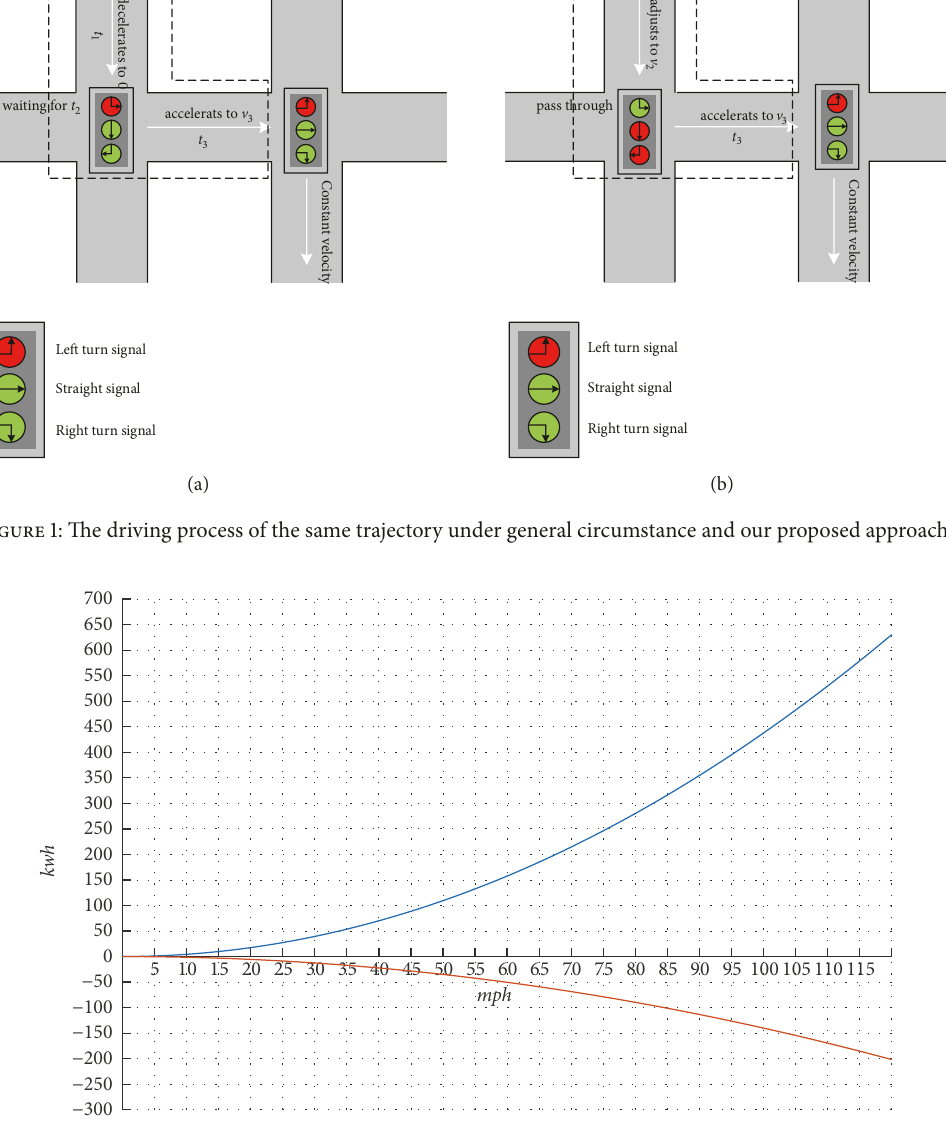
3 and 4, which represents two directions (such as go straight and turn right) controlled by the signal phrases. Node 2 can be split into nodes 2 󸀠 and 2 󸀠󸀠 . As for node 4, it is connected by nodes 2 and 3, which can be split into nodes 4 󸀠 and 4 󸀠󸀠 in the same way. The number marked on the arrow is the travel time of the link. Then, the network structure is also changed due to the addition of